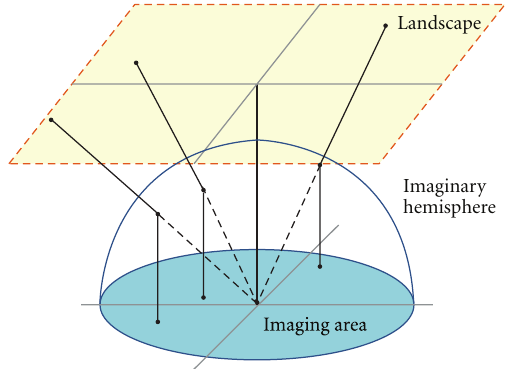
Figure 6: Principle for capturing with a circular fisheye-lens camera.